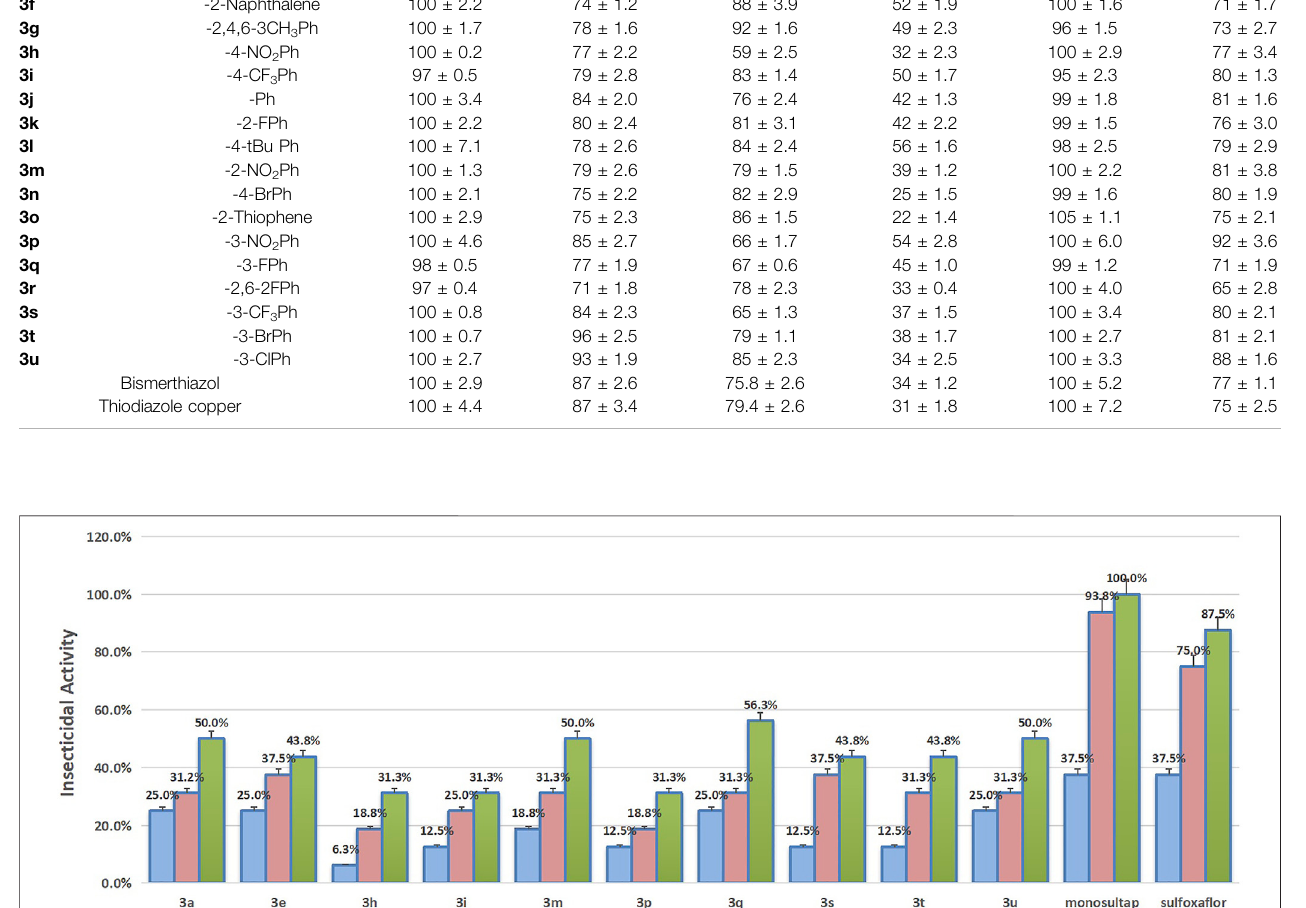
Frontiers in Chemistry |